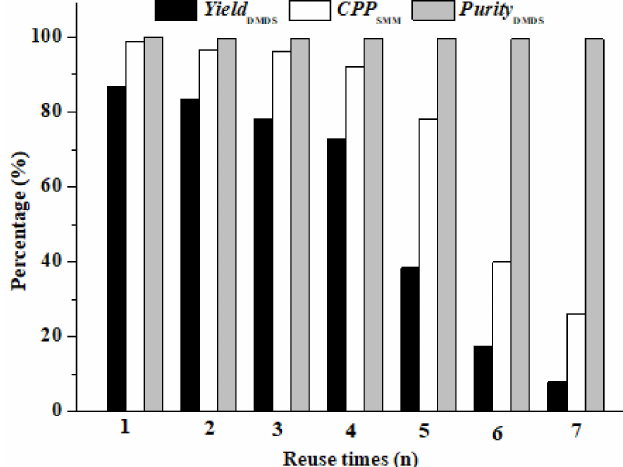
Figure 11. The effect of reuse times of new AC-CoPcS catalyst on CPP SMM , Yield DMDS , and Purity DMDS. Experimental conditions: SMM (18.0 wt%) 450 g, RR = 600 r/min, C ca = 888.9 ppm, t = 60 min, T re = 65 ◦ C, P (O 2 ) = 0.9